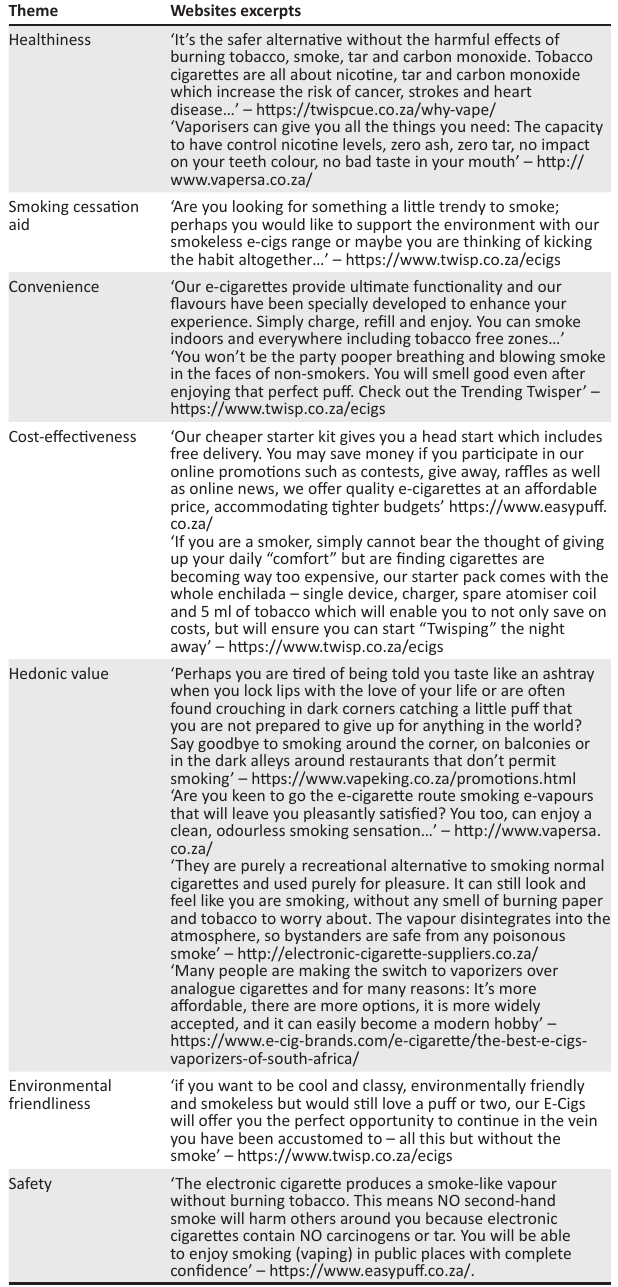
TABLE 1: Content analysis of e-cigarettes retail